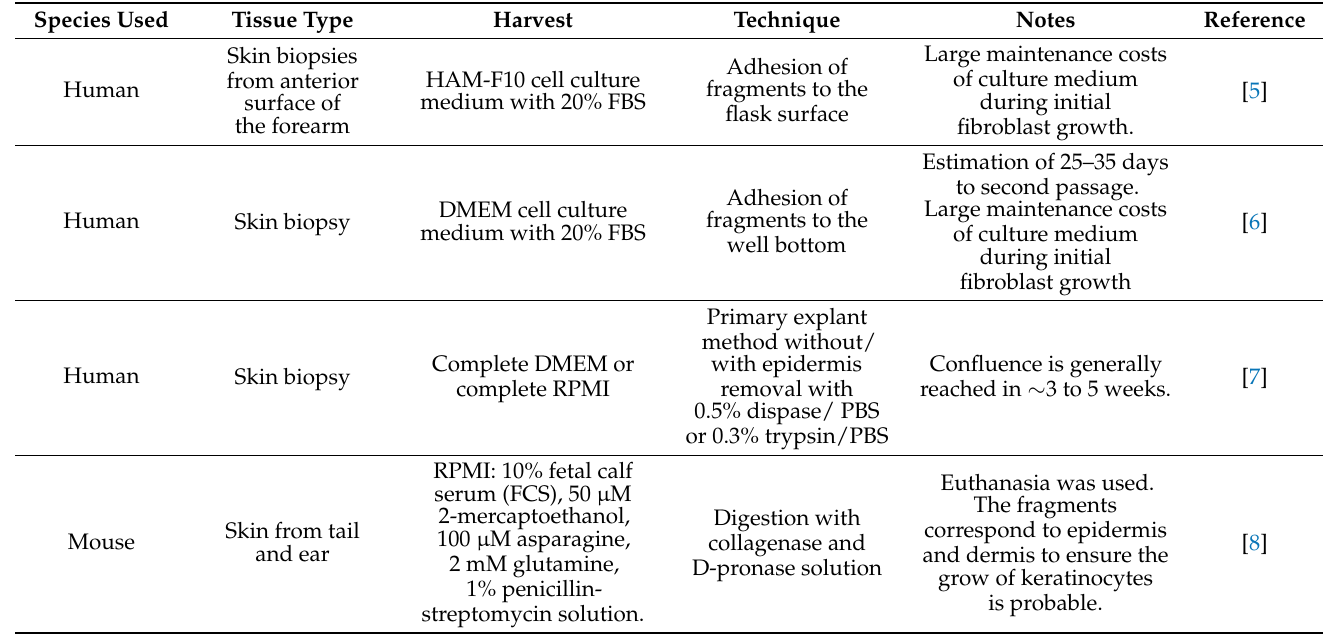
Table 1. Available techniques for primary fibroblasts